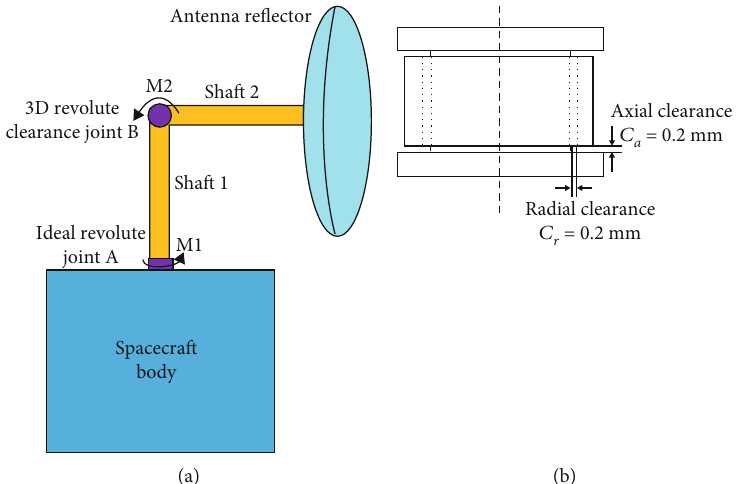
Figure 6: Schematic of satellite antenna system with 3D revolute clearance joint: (a) structure of the satellite antenna system; (b) 3D revolute clearance joint B with radial and axial clearances. Table 1: Structural parameters of satellite antenna system. Table 2: Parameters used in the dynamic simulation.